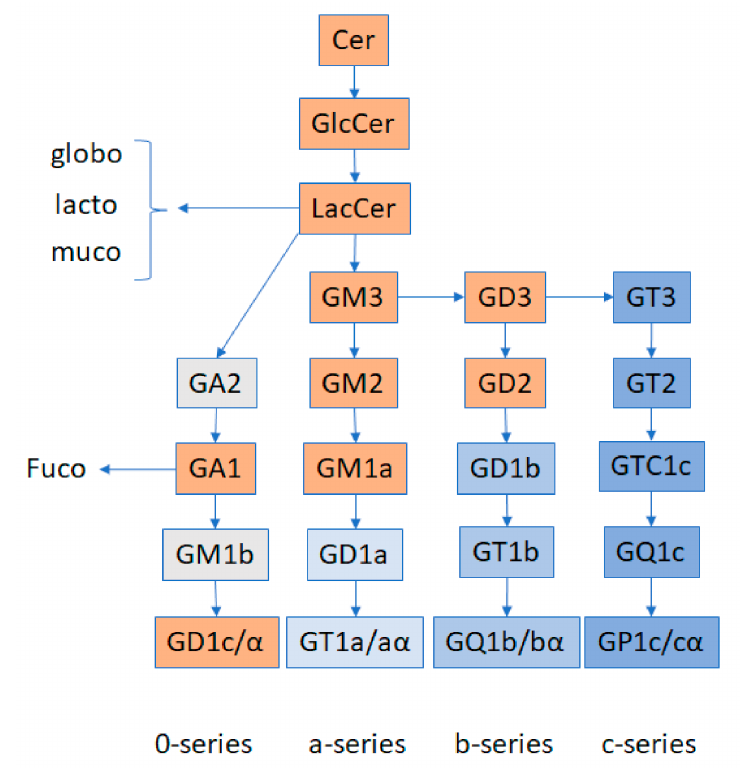
Figure 2. Schematic representation of ganglioside biosynthesis pathways. LacCer are the precursors of the globo, lacto, muco, and ganglio series of glycosphingolipids. GM3 are the precursors of the a, b, and c series of gangliosides. LacCer are precursors of asialo (0-series) gangliosides (GA). GA1 give way to fucosylated glycosphingolipids. “ / ” denotes two di ff erent structures of gangliosides produced from the same precursor. “ α ” denotes specific ganglioside structures in which one sialic acid residue is branched to N-acetylgalactosamine (GalNAc). All the other sialic acid residues are branched to galactose residues (modified from [5]). The orange colored rectangles denote the molecular species whose abundance has been reported to date as changed in the context of podocytopathies (summarized in Table 1). Many of these reactions are reversible. GM: Monosialo gangliosides; GD: Disialo gangliosides; GT: Trisialo gangliosides; GQ: Quadrisialo gangliosides; GP: Pentasialo